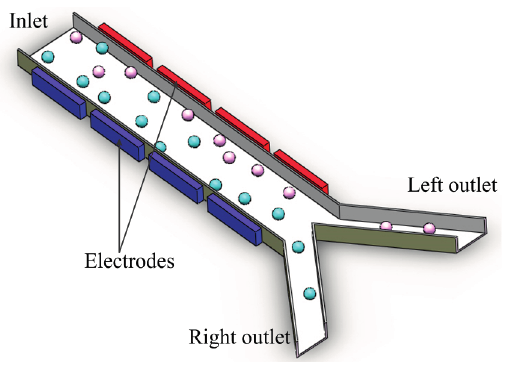
Figure 15. Schematic diagram of the microchip for particle separation based on dual frequency